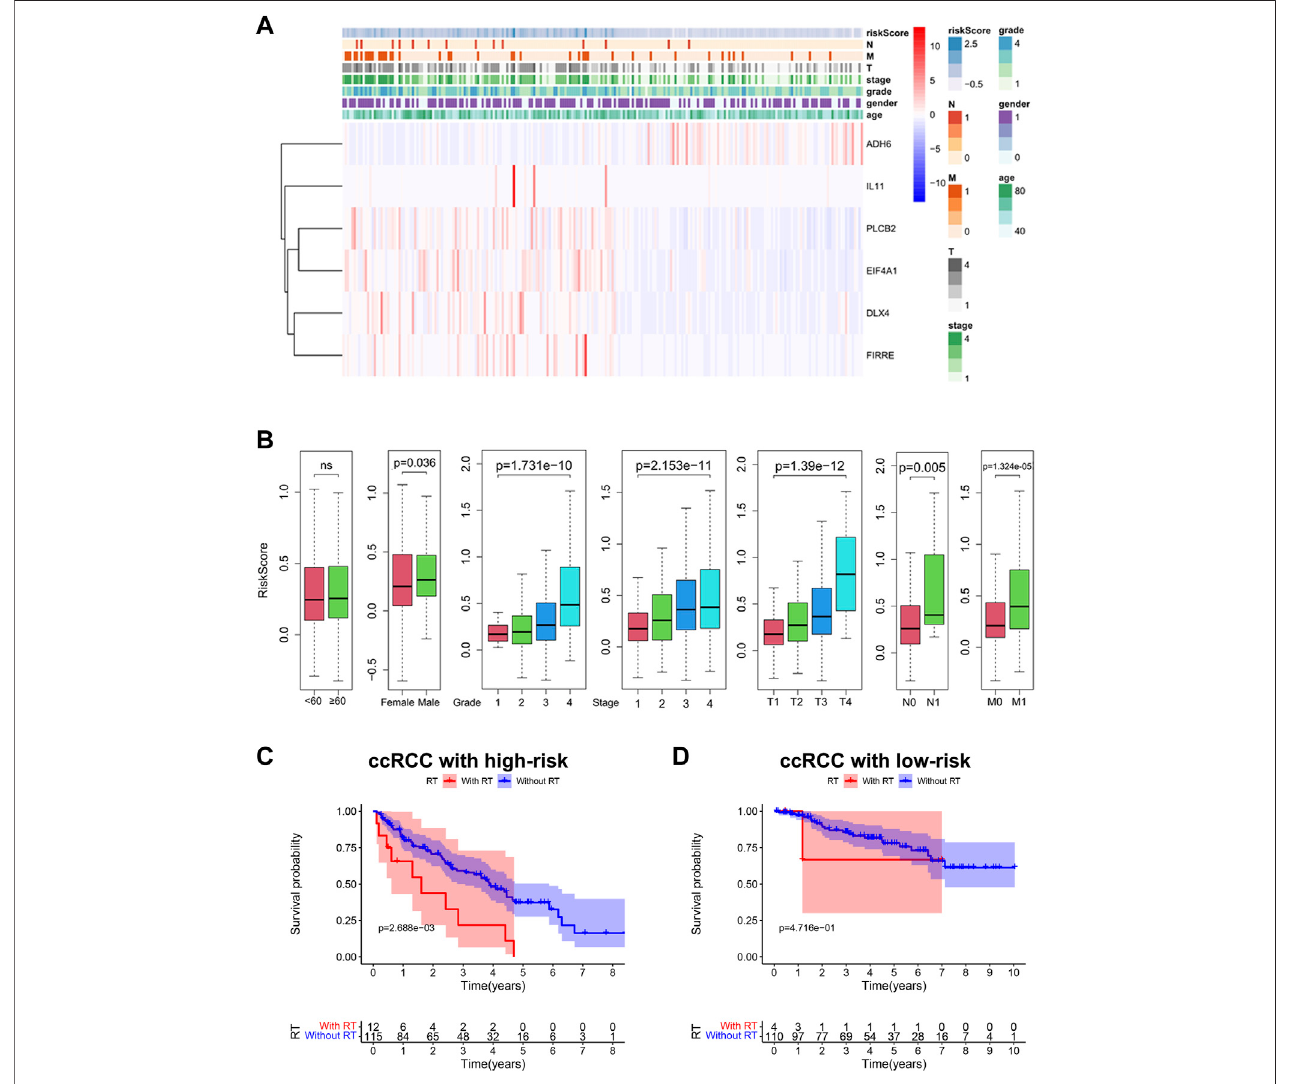
FIGURE 5 | Bu-Meta-GPS correlated with clinical features and radiotherapy. (A) Heatmap of the association between the expression levels of the Bu-Meta-GPS and clinicopathological features. (B) Correlation of risk scores with age, gender, grade, stage, T, M, and N. Kaplan – Meier curves of OS for ccRCC patients subjected to radiotherapy in the high-risk group (C) and low-risk group (D) (ns, not statistically signi fi cant).